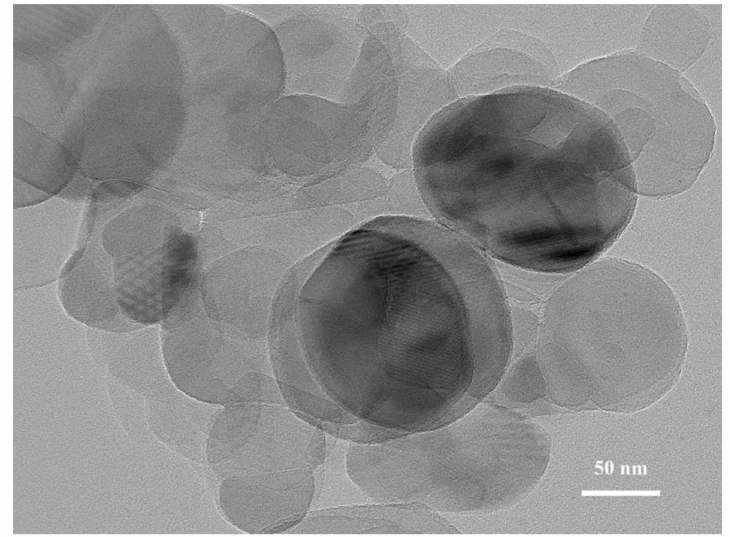
Figure 4. TEM image of BN